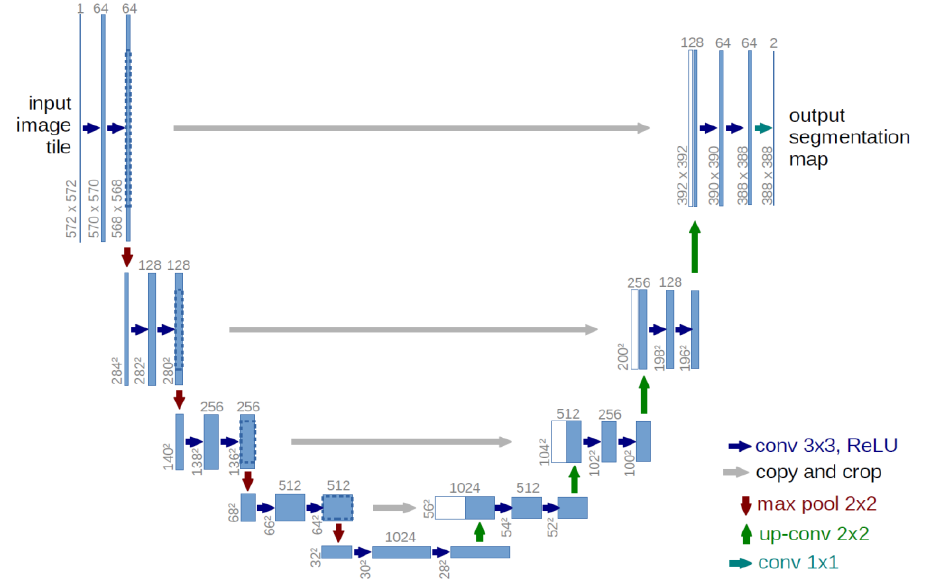
Figure 12. Scheme of 3D-UNet. Table 4. Segmentation accuracy and Dice similarity coefficient (DSC) results